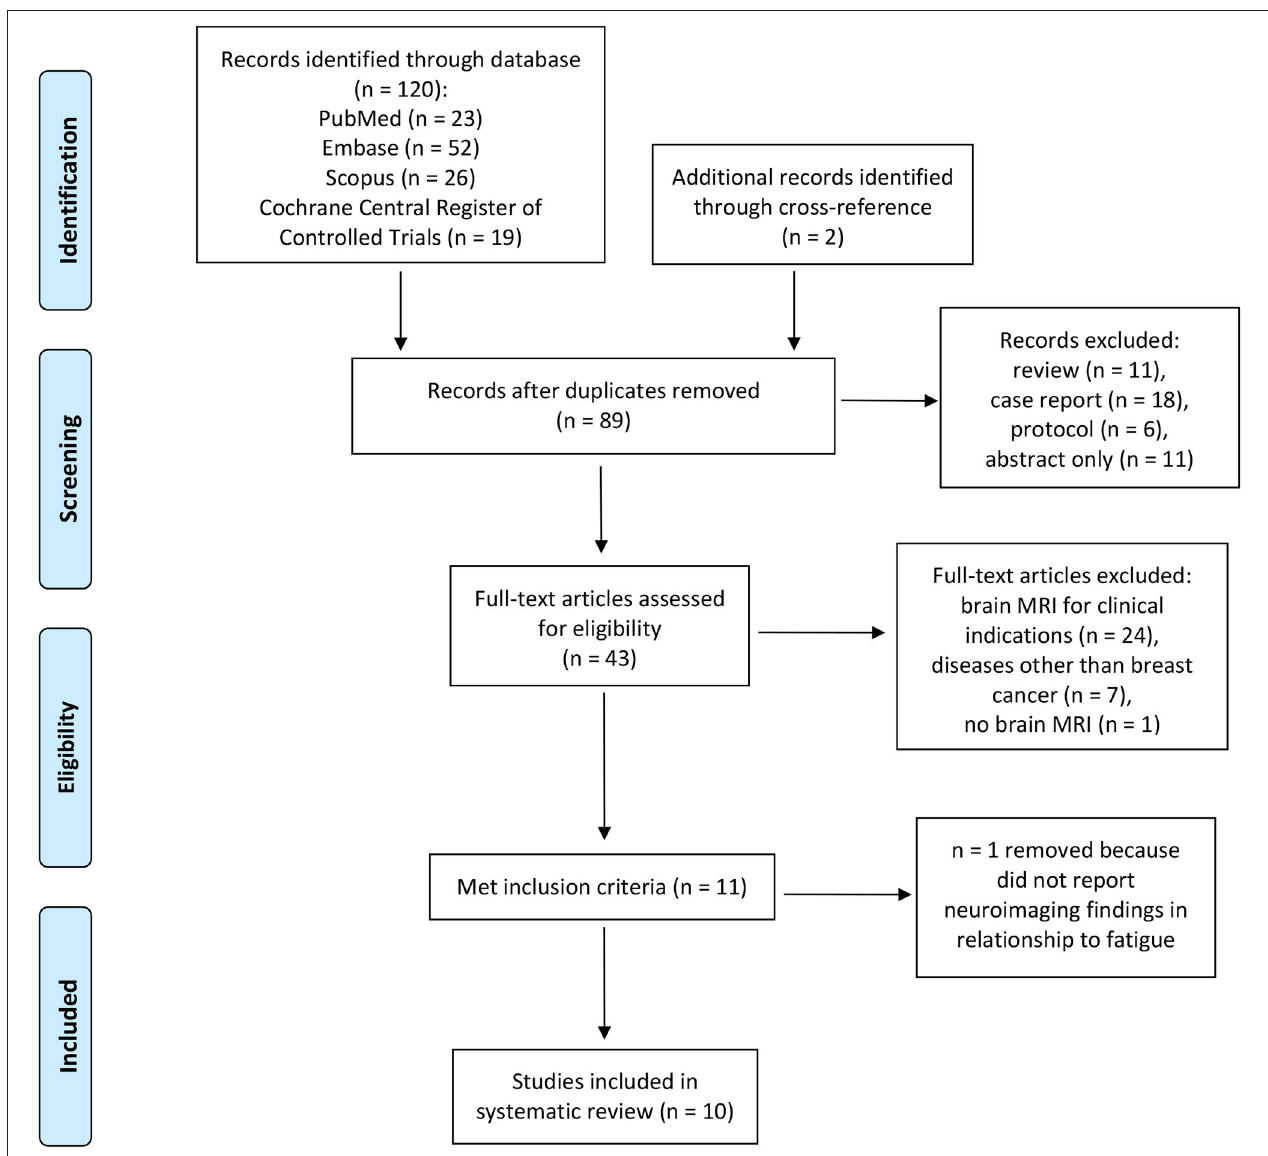
FIGURE 1 | PRISMA flow diagram of functional MRI studies on breast cancer related fatigue